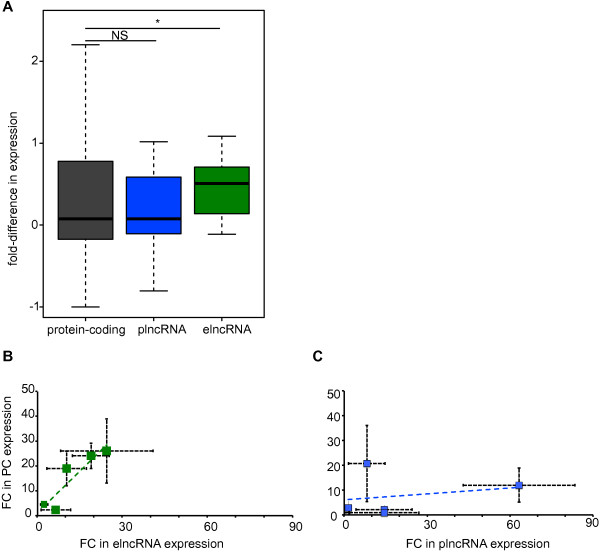
Expression of elncRNA but not plncRNA loci is associated with enhanced expression levels of neighboring protein-coding genes. (A) Fold difference, Δ, in expression of the neighboring loci in the stage in which the expression level of the reference locus (protein-coding gene, plncRNA or elncRNA) is maximal relative to the stage in which it is minimal. Δ is defined as (Expressionmax - Expressionmin)/Expressionmin. Two-tailed Mann–Whitney test, *P < 0.05; NS, not significant. Fold-change (FC) between Ter119+ and colony-forming unit erythroblast (CFUE) expression (measured by quantitative PCR) of (B) elncRNAs (green) or (C) plncRNAs (blue) (x-axis) and their respective protein-coding gene (PC, y-axis). Data used for the preparation of this figure are available in Additional file 16. Horizontal and vertical bars represent the standard error of the mean for fold-change of lncRNA and protein-coding genes, respectively. Dashed blue and green lines represent the elncRNAs’ and plncRNAs’ linear regression functions, respectively.